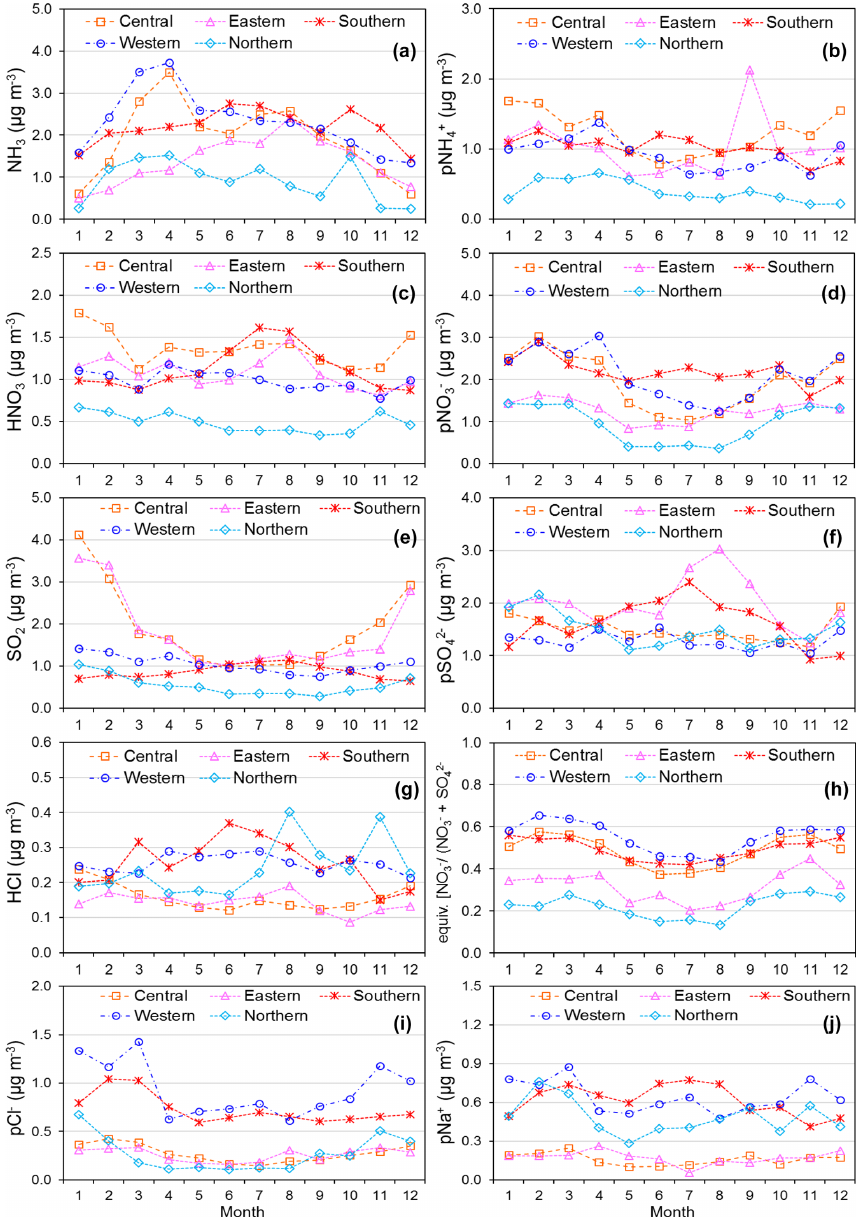
Figure 15. Seasonal variability at sites grouped according to European regions in atmospheric gas (a) NH 3 , (c) HNO 3 , (e) SO 2 , (g) HCl) and aerosol concentrations (b) pNH + , (d) pNO − , (f) pSO 2 − , (i) pCl − , (j) pNa + ( p in front of component name denotes particulate). Each 4 3 4 data point is the monthly averaged concentrations of grouped sites for the period 2006 to 2010, classified according to five European regions: central ( n = 17), eastern ( n = 2), northern ( n = 11), southern ( n = 12), and western ( n = 26). Graph (h) shows the monthly mean ratio of + SO 2 molar-equivalent (equiv.) concentrations of NO − to sum (NO − ). Month 1: January; Month 12: 3 3 4